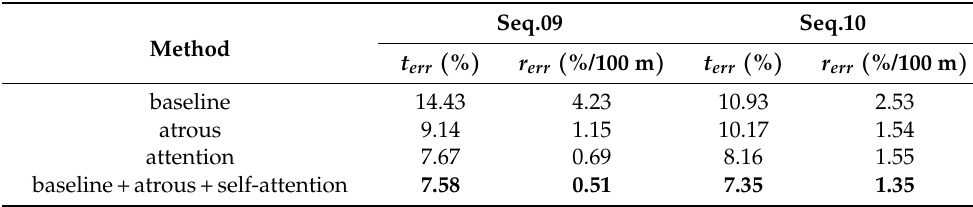
Figure 7. Trajectory results of ablation studies in sequence 09 ( a ) and sequence 10 ( b ) of KITTI dataset. Table 3. Ablation study for various versions of our method on KITTI sequence 09 and 10. The least error results are highlighted in bold text. The boldface represents the best